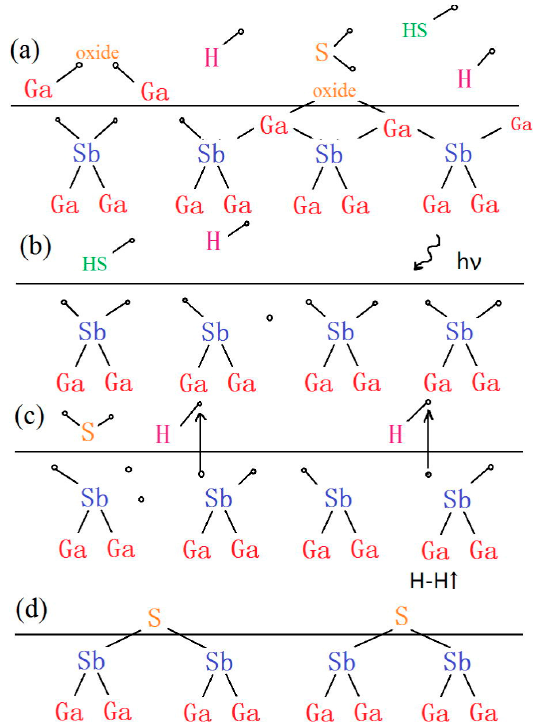
Figure 10. Schematic showing the chemical bonds between sulfur and other atoms formed at the semiconductor surface. Reproduced with permission from [8], copyright NORTH-HOLLAND (2013).